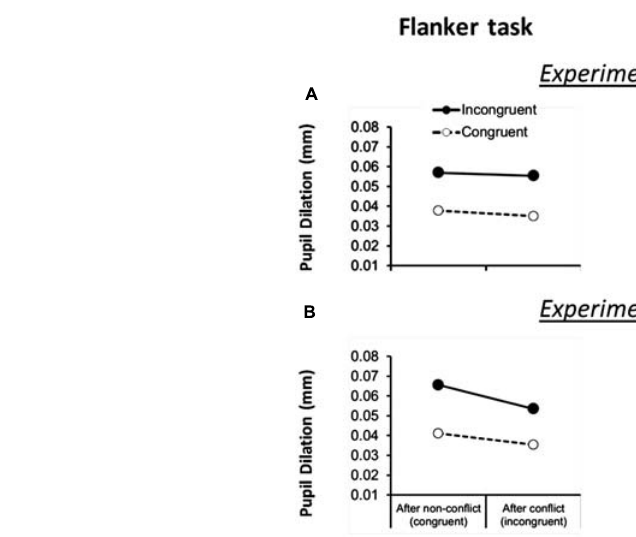
that there is a current-trial congruency × previous-trial congruency interaction effect. However the task × current-trial congruency × previous-trial congruency interaction effect is not significant.